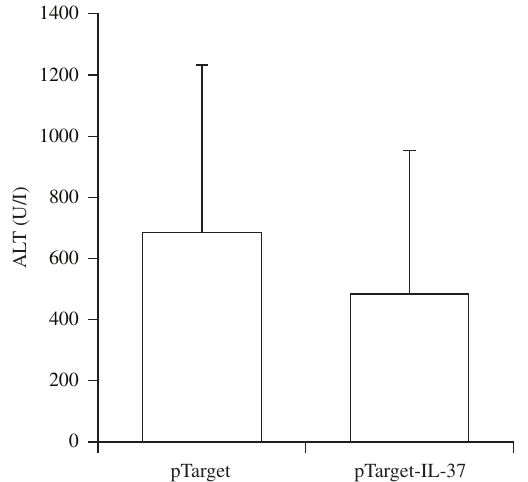
FIGURE 4: Serum ALT levels in ConA-induced hepatitis. Serum ALT was measured in tail-vein-injected C57/Bl6 mice (with or without IL-1F7b cDNA, n = 3 -4) 24 h after ConA treatment. Serum ALT levels were measured by a Hitachi 917 Analyzer.